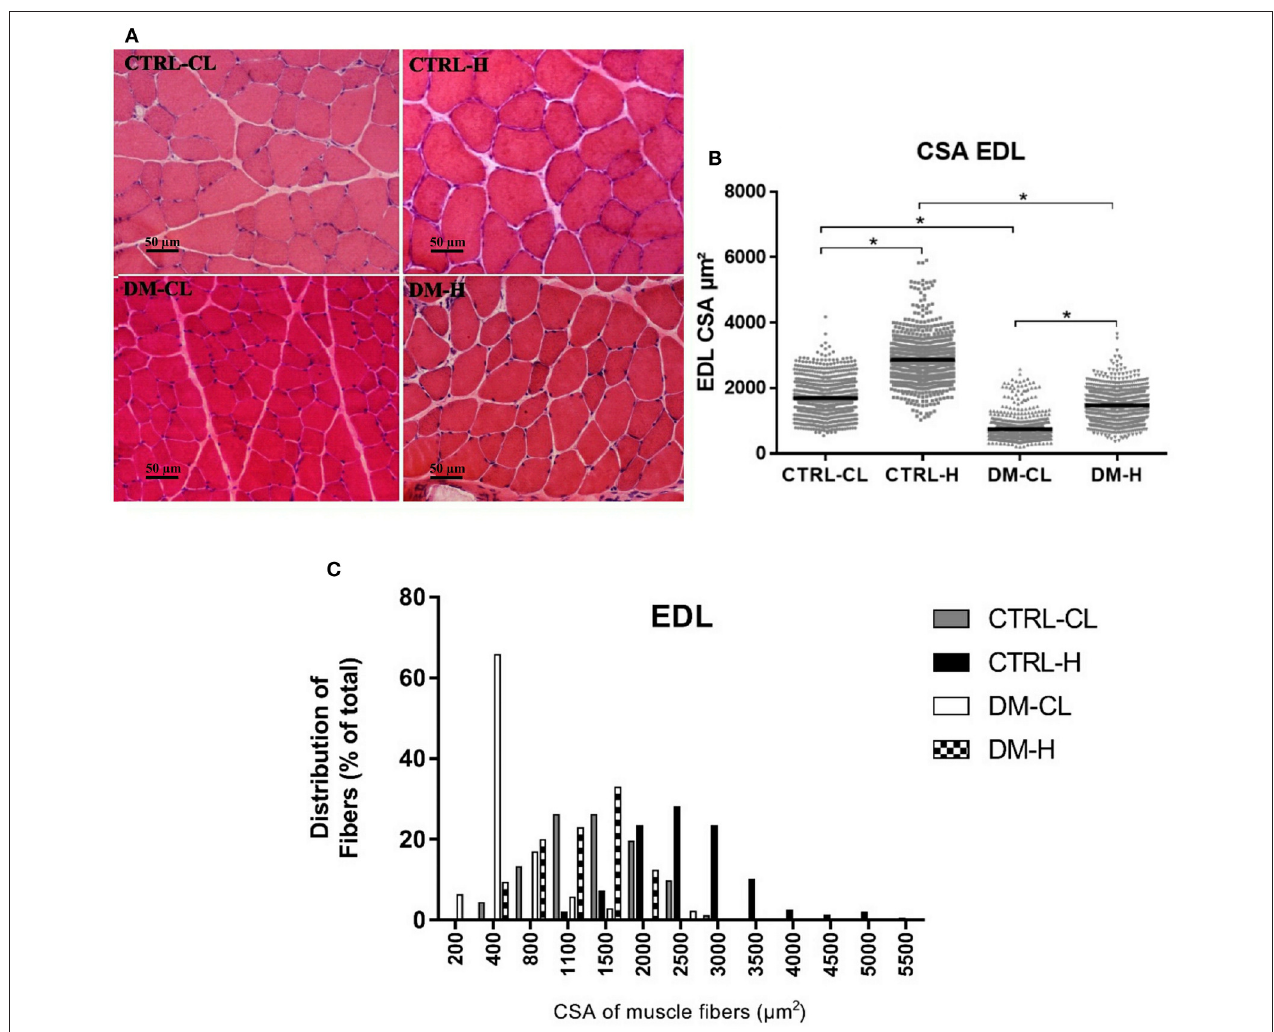
FIGURE 2 | Cross-sectional areas (CSA) of the EDL muscle fibers. (A) Representative histological hematoxylin and eosin staining images of EDL muscle CSA. Reference bar represents 50 µ m. (B) Dispersion graph of EDL muscle fibers CSA. (C) Frequency distribution of the EDL muscle fibers according to CSA ranges: 0–5,500 µ m 2 . The results were analyzed as previously described using the 95% confidence interval of the median. *Significant different considering the 95% confidence interval of the median. CTRL-CL, control group, contralateral muscle; CTRL-H, control group, hypertrophied muscle; DM-CL, diabetic group, contralateral muscle; DM-H, diabetic group, hypertrophied